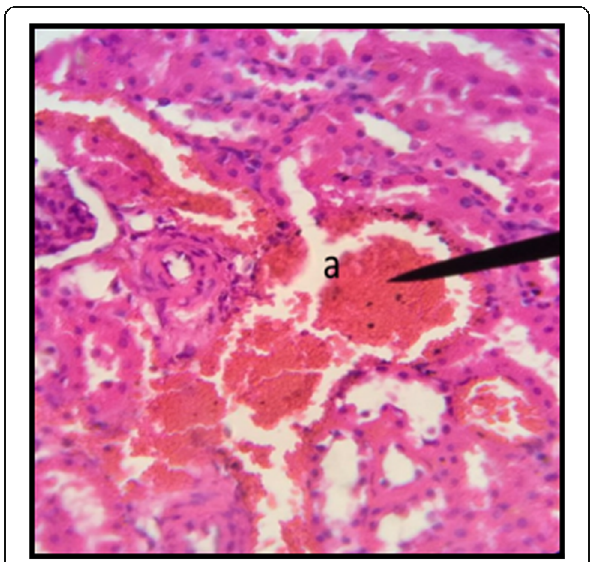
Fig. 5 Kidney Section of Male Rat (50 mg/kg/day) X400. a normal glomerulus, b little bit dilation of peritubular capillaries, c normal proximal tubule